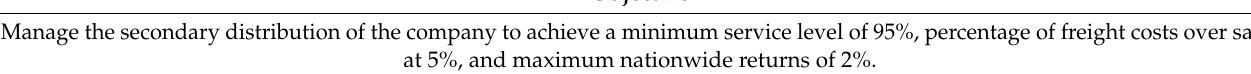
Table 10. Master plan for the secondary distribution.